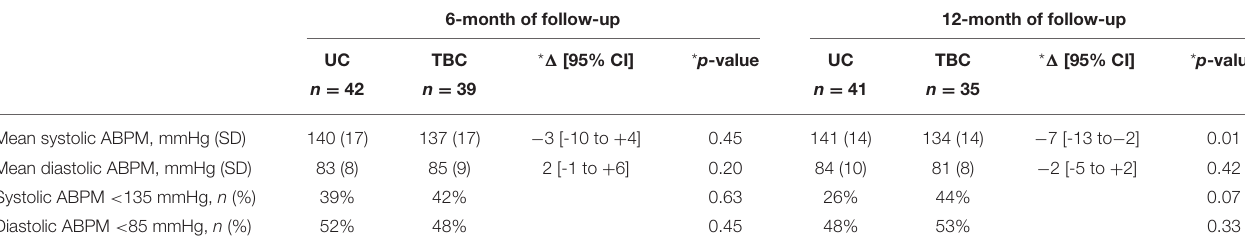
TABLE 3 | Daytime systolic/diastolic ambulatory blood pressure monitoring (ABPM) and control at 6- and 12-month of follow-up. 6-month of follow-up 12-month of follow-up